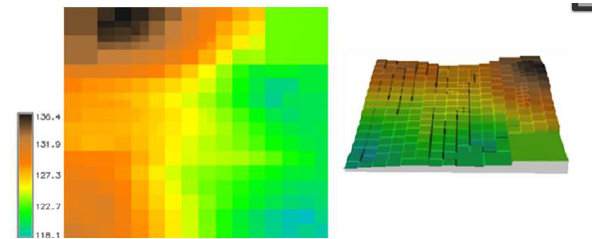
Figure 9. 0.1 tension parameter, 20 smoothing parameter 275 anisotropy angle and 0.25 anisotropy scale factor